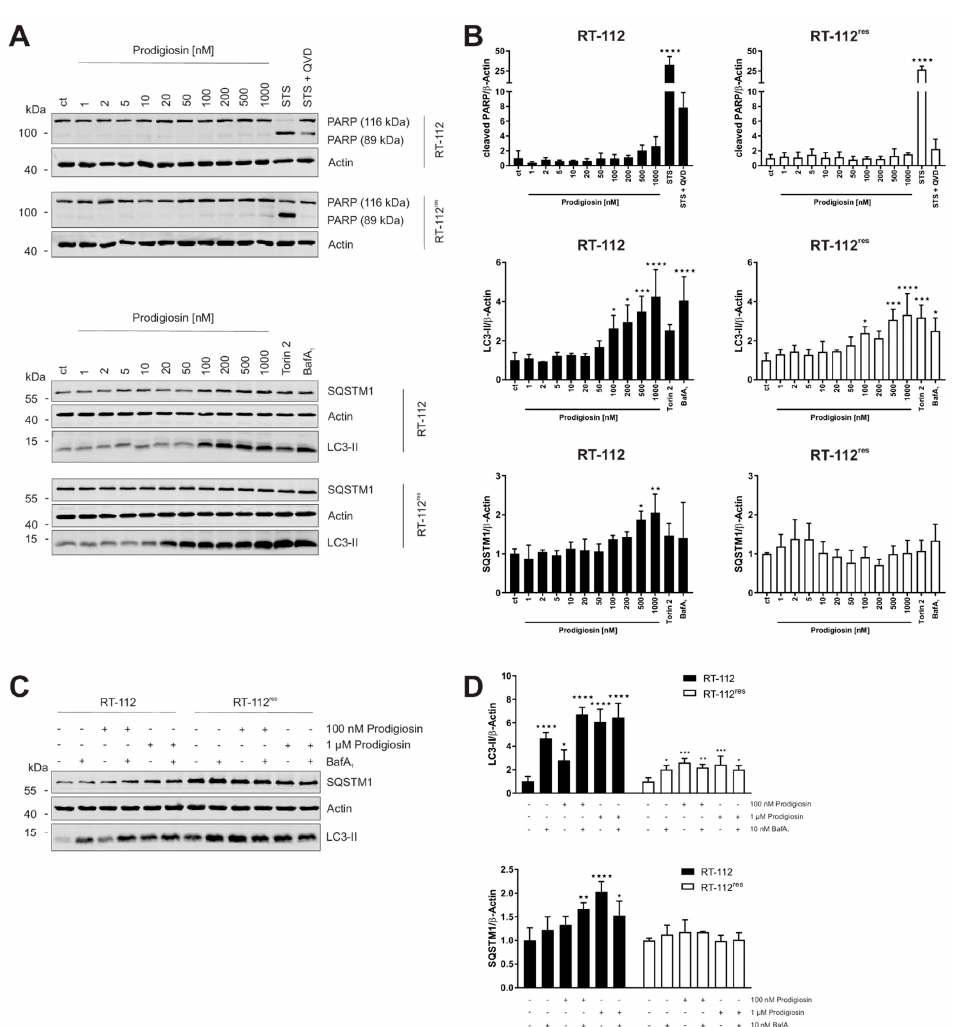
Figure 3. Prodigiosin modulates autophagy in RT - 112 and RT - 112 res in a concentration-dependent manner. RT - 112 and RT - 112 res cells were treated with the indicated concentrations of prodigiosin or 2.5 µM STS ± 10 µM QVD, 10 nM bafilomycin A 1 (BafA 1 ) or 250 nM Torin 2. After 6 h, the cells were lysed and cellular lysates were immunoblotted for the indicated proteins. ( A,C ) One representative immunoblot is shown for each experiment. ( B,D ) The densities of the bands of each protein of at least three independent experiments were quantified and normalized to actin. The mean of the solvent control of RT - 112 (black bars) and RT - 112 res (white bars) was set as 1 for each protein. Bars represent the means + SD. P values were determined by ordinary one-way ANOVA with Dunnett´s post hoc test. * p < 0.05; ** p < 0.01; *** p < 0.001; **** p < 0.0001. PARP: poly (ADP-ribose) polymerase; SQSTM1: sequestosome 1; LC3: light chain 3.